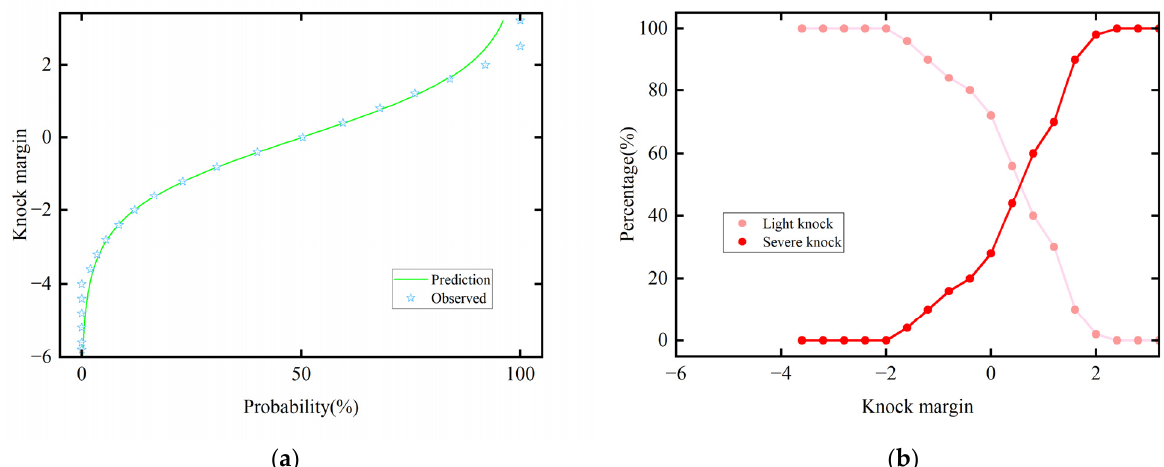
Figure 8. Knock margin of prediction system.